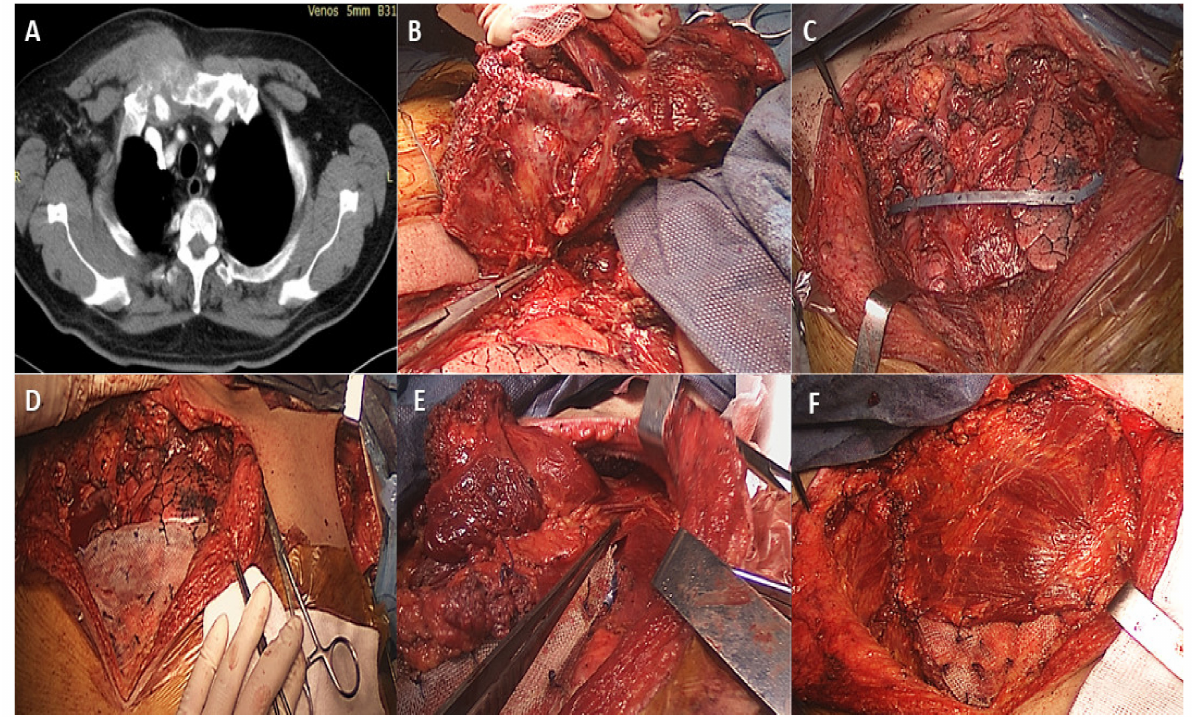
Figure 4. ( A ) Preoperative CT scan of a 55-year-old patient diagnosed with a manubrial tumor. ( B ) A large resection of the tumor was performed, within oncological limits. ( C ) After resection, rigid reconstruction was performed using a Stratos titanium bar on the upper side of the operative field. The medial part of the clavicle is shown. ( D ) Next, a polypropylene mesh was utilized in the left upper corner. The incision used for sectioning of the deltoid tuberosity insertion of the left pectoralis major is shown. ( E ) For soft-tissue reconstruction, a pectoralis major flap was harvested (main pedicle at the tip of the clamp). ( F ) The intraoperative aspect with the pectoralis major flap was secured over the polypropylene